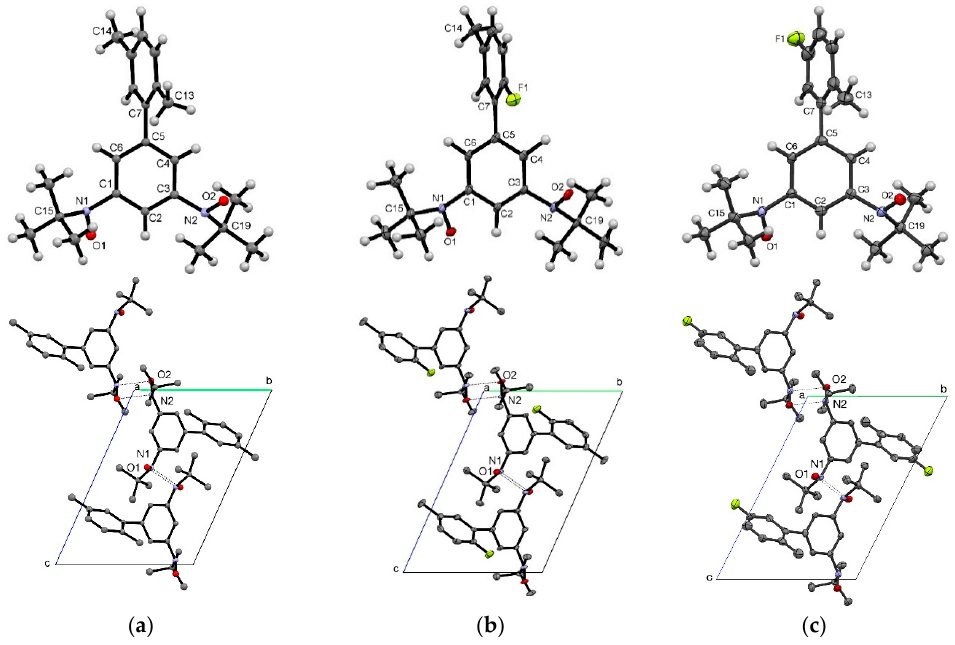
Figure 1. Molecular structure (top) and molecular arrangement (bottom) in the crystals of ( a ) α -25Me, ( b ) 2F5Me-, and ( c ) 5F2MeBPBN. Selected atomic numbering is also shown. Hydrogen atoms are omitted in the bottom panels. Short contacts are denoted with dotted lines.